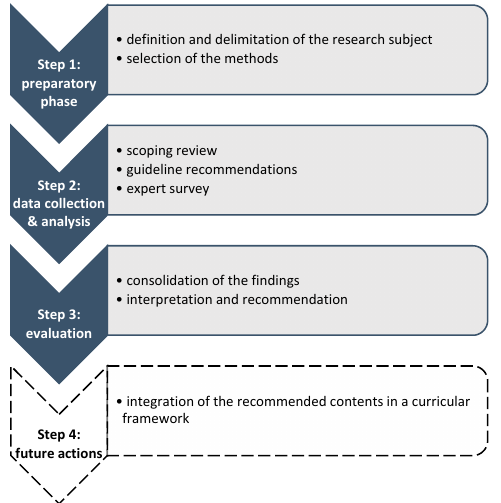
Figure 1. Theoretical framework of the study. The grey parts of this figure have been finished and are reported in this article. The white part remains to be done in the future. 2.2.2. Selection Criteria After de-duplication, the abstracts and eligible full texts were assessed by two au- thors (ML, KK) independently according to predefined criteria. Inclusion: articles written